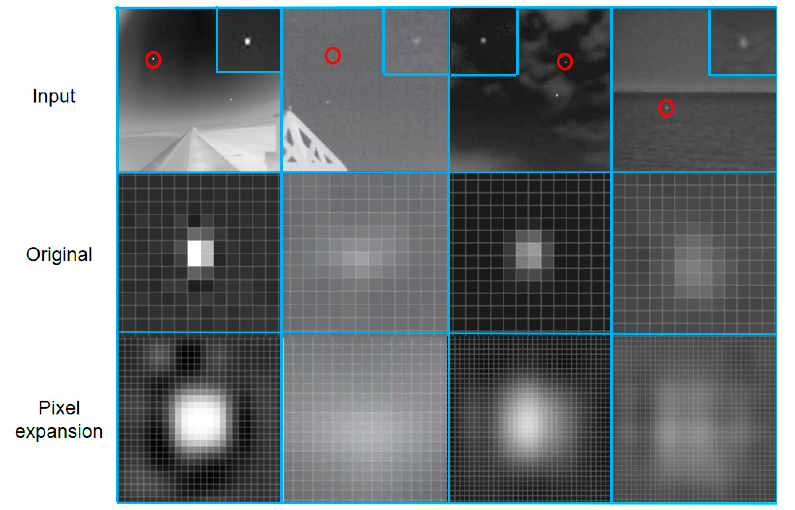
Figure 13. Detection results before and after upsampling. 4.4.3. Comparison of Test Results As shown in Figure 14, we compare the detection results after target feature en- hancement and pixel expansion with those for the DNANet algorithm. It can be seen that there is an overall improvement in detection after the processing of our algorithm. The results show that in row (a), DNANet has a problem of inadequate recognition of this target, recognizing only part of the target due to the fact that some pixel values at the edges of the target are slightly below the banalization threshold ε . The number of pixels that meet the constraints is small. After processing by our algorithm, the pixel values of the target edges were increased and the pixel points were expanded, resulting in some improvement in the detection results.